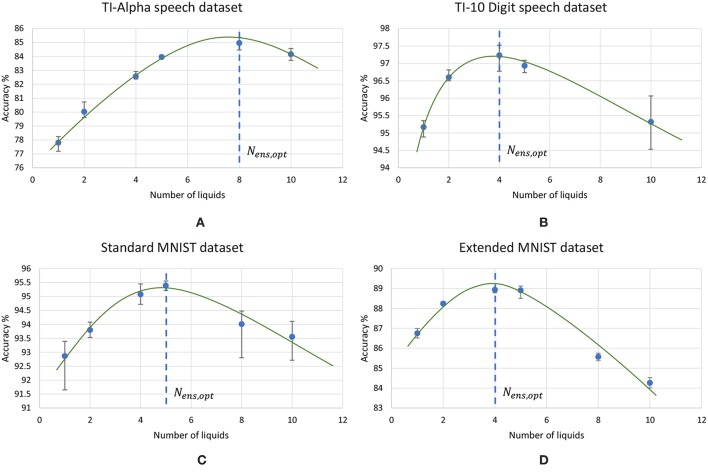
The average (over five trials) accuracy (percentage) trends with different number of liquids in an ensemble, for two speech recognition tasks; (A) TI-alpha test dataset, (B) TI-10 test dataset, and two image recognition tasks; (C) standard MNIST test dataset, (D) extended MNIST test dataset. The total number of neurons in each ensemble of liquids were kept the same. Note that all the accuracy trends peak at a certain point, that depends on the application.